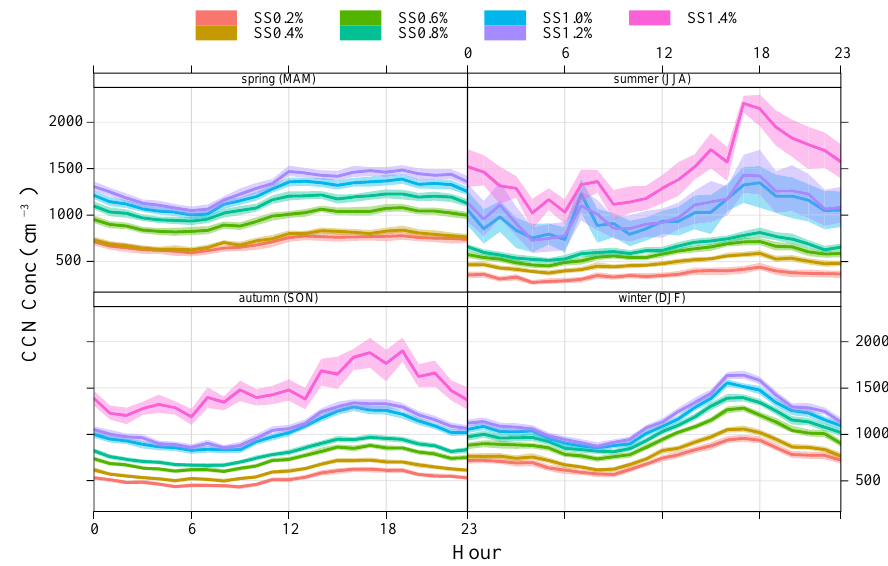
Figure 6. Seasonal diurnal variation in CCN in LPS. Table 1. The seasonal average value of different levels of supersaturation.